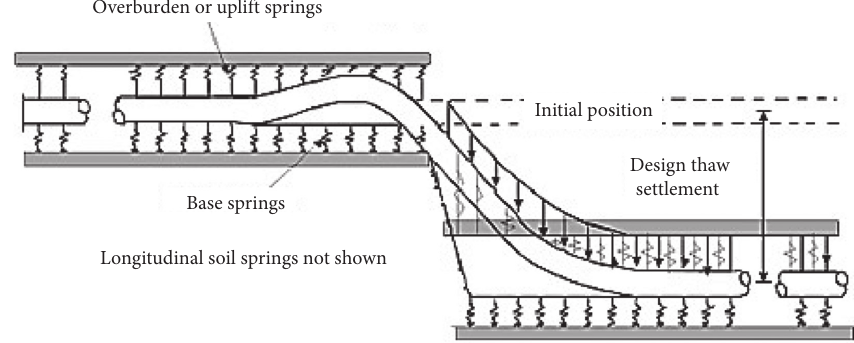
Figure 16: Finite-element model of a shell element in collision with the